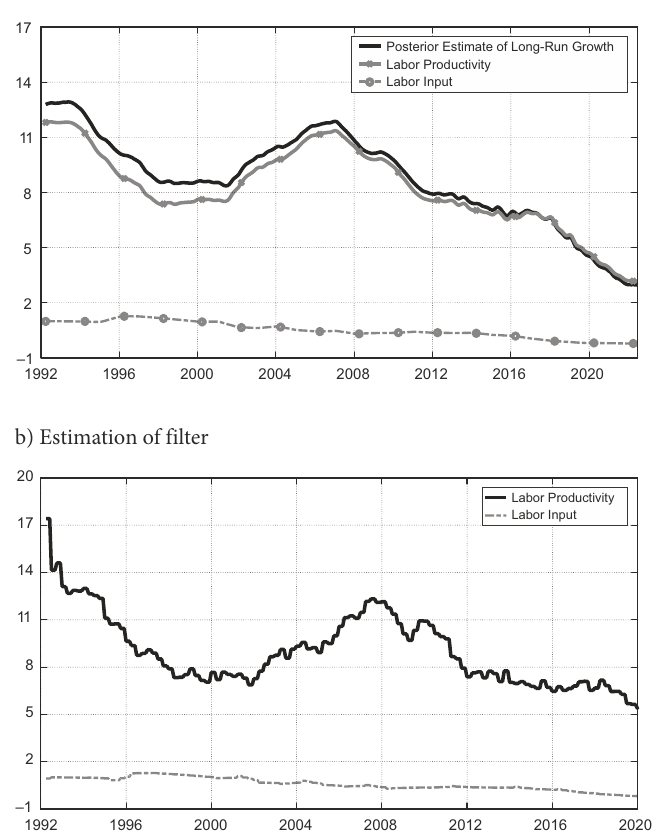
a) Estimation of posterior